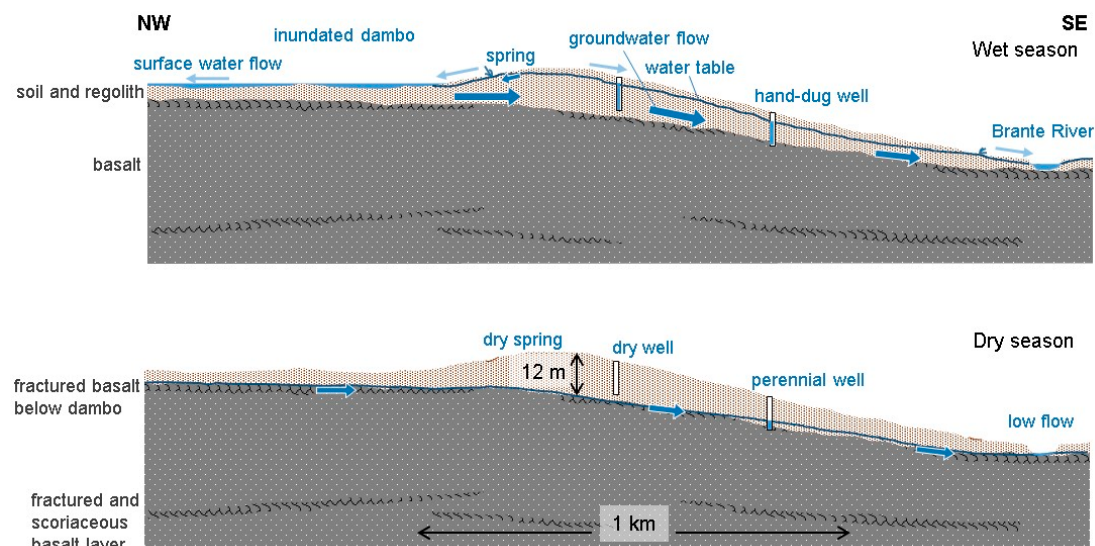
Figure 9. Schematic cross-sections showing the conceptual model during the wet and dry seasons. The cross-section represents a common profile at the study site, e.g., the NW-SE line shown in Figure 7a. Note the very shallow groundwater flow (and unsaturated zone flow) in contrary directions to the dominant regolith aquifer groundwater flow during the wet season and groundwater flow contrary to surface water flow at the up-gradient dambo.